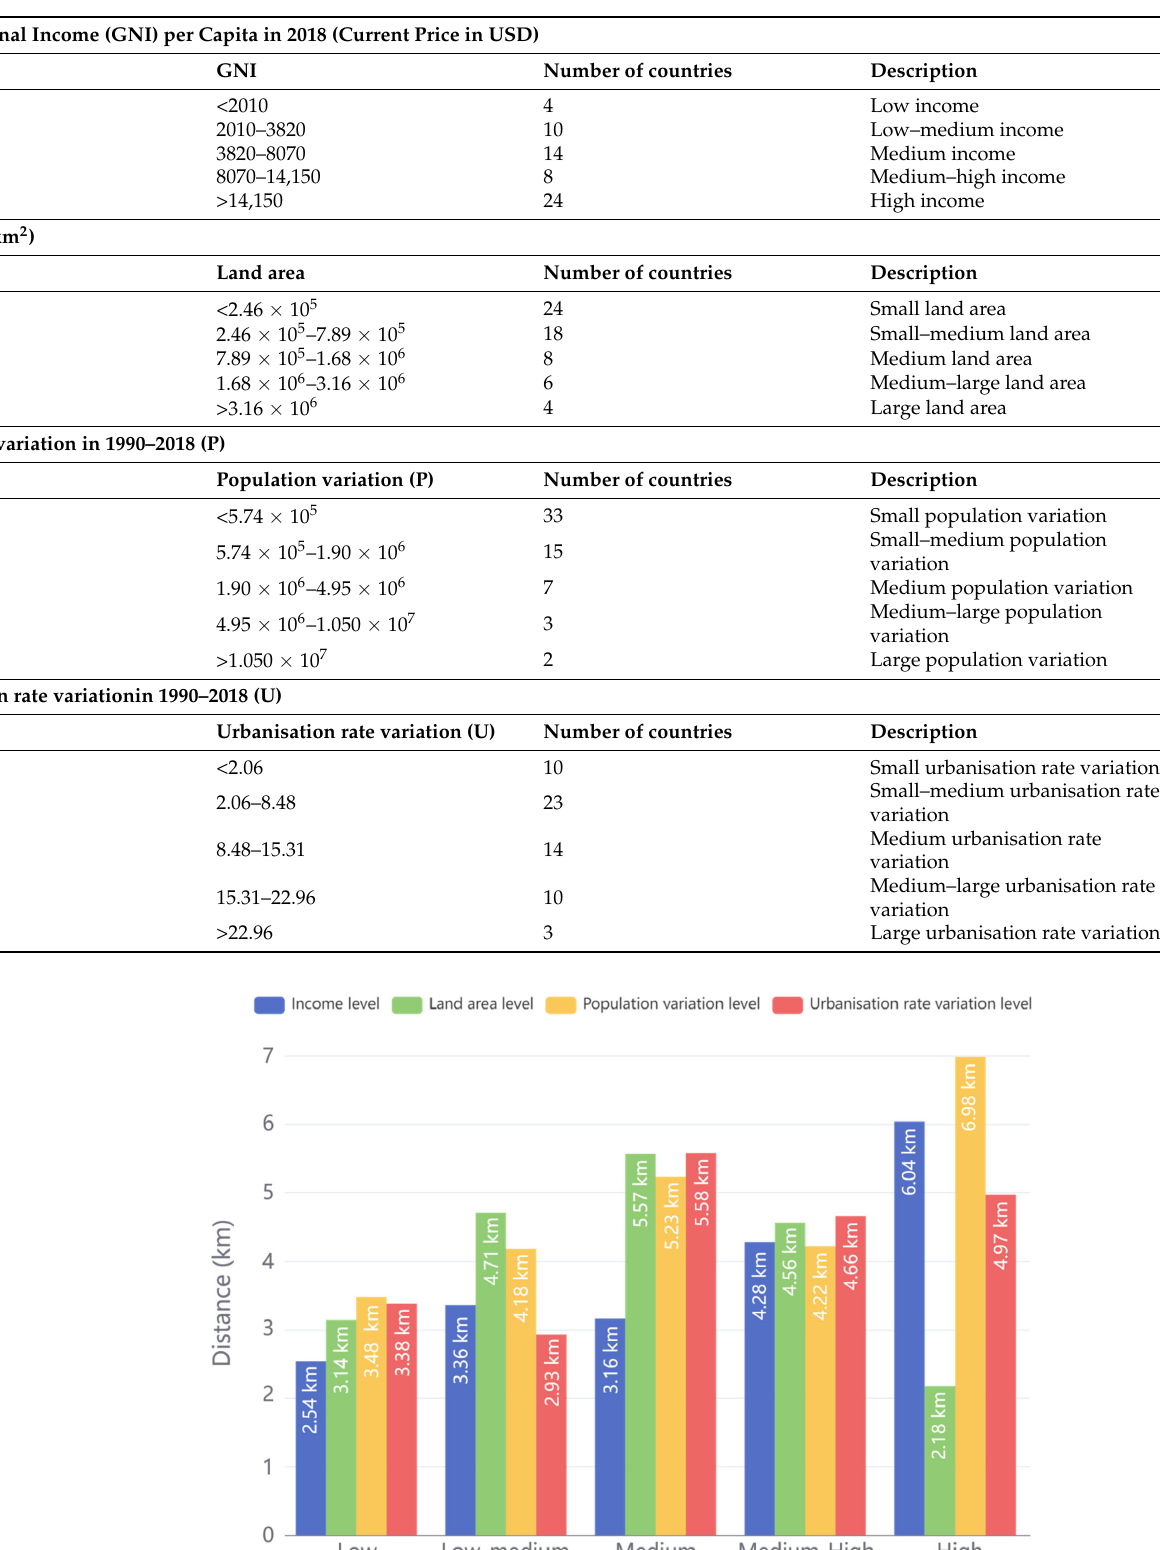
Table 6. Sixty countries are graded for each indicator.